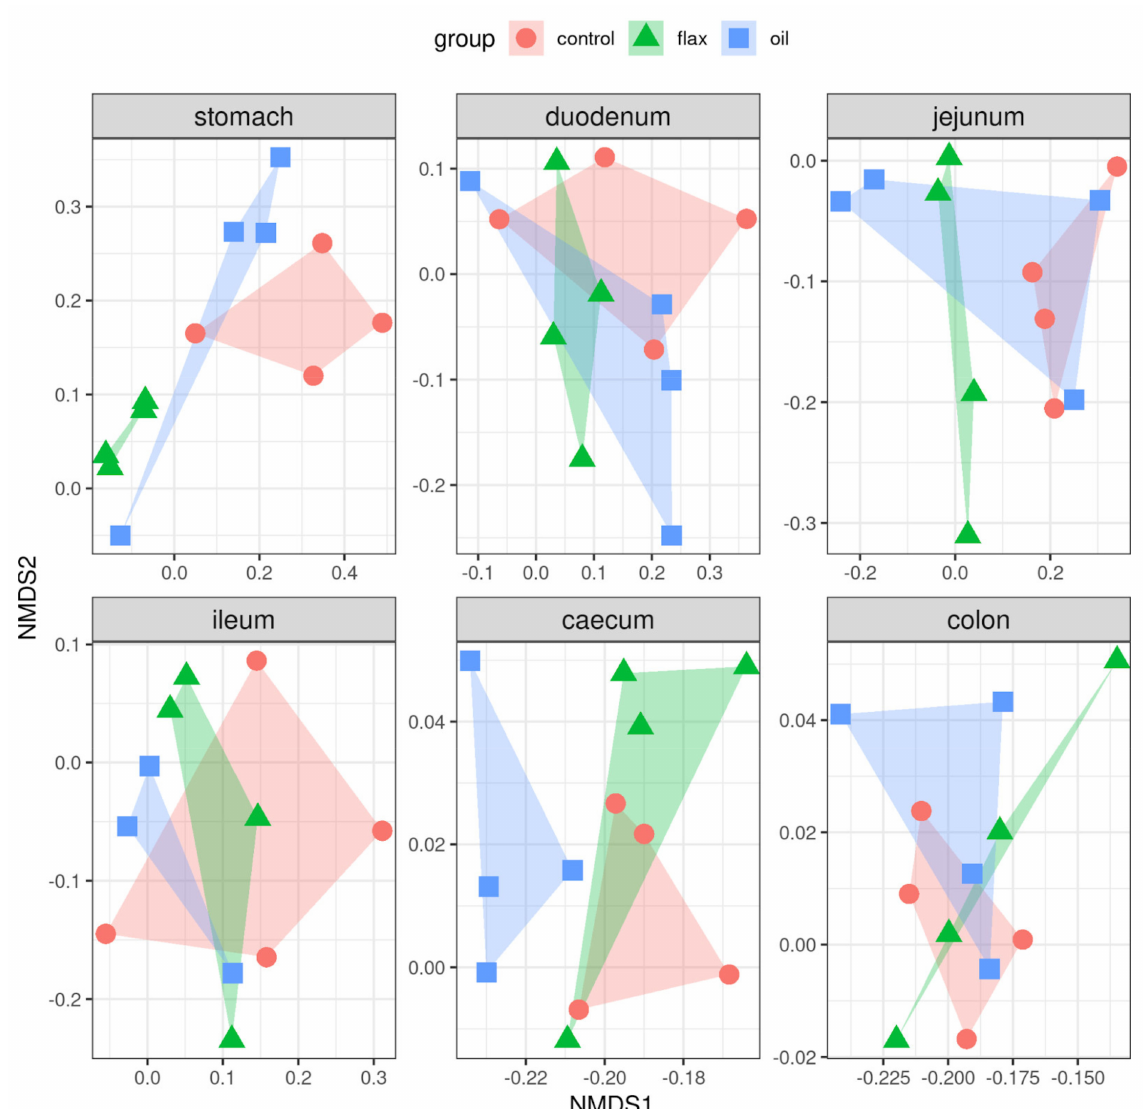
Figure 6. MDS plot of Bray–Curtis distances based on the filtered and normalized OTU table. ClusTable 5. group) along the rabbits’ digestive tract. p -values from permutational analysis of variance (PERMANOVA) with 999